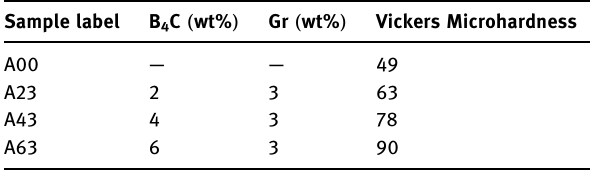
Table 3: Microhardness results of with and without adding B 4 C